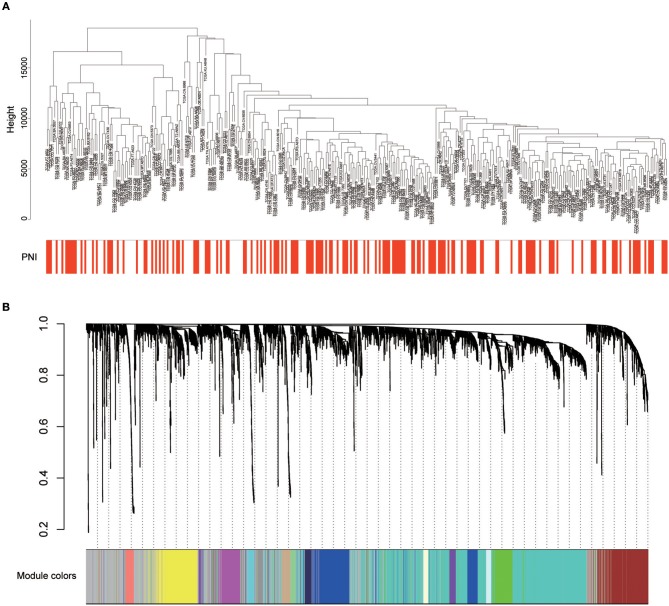
(A) Cluster analysis of HNSCC expression data after removing outliers. (B) Clustering dendrogram of genes. A hierarchical cluster analysis dendrogram was used to detect coexpression clusters. Each color is assigned to 1 module (gray represents unassigned genes).